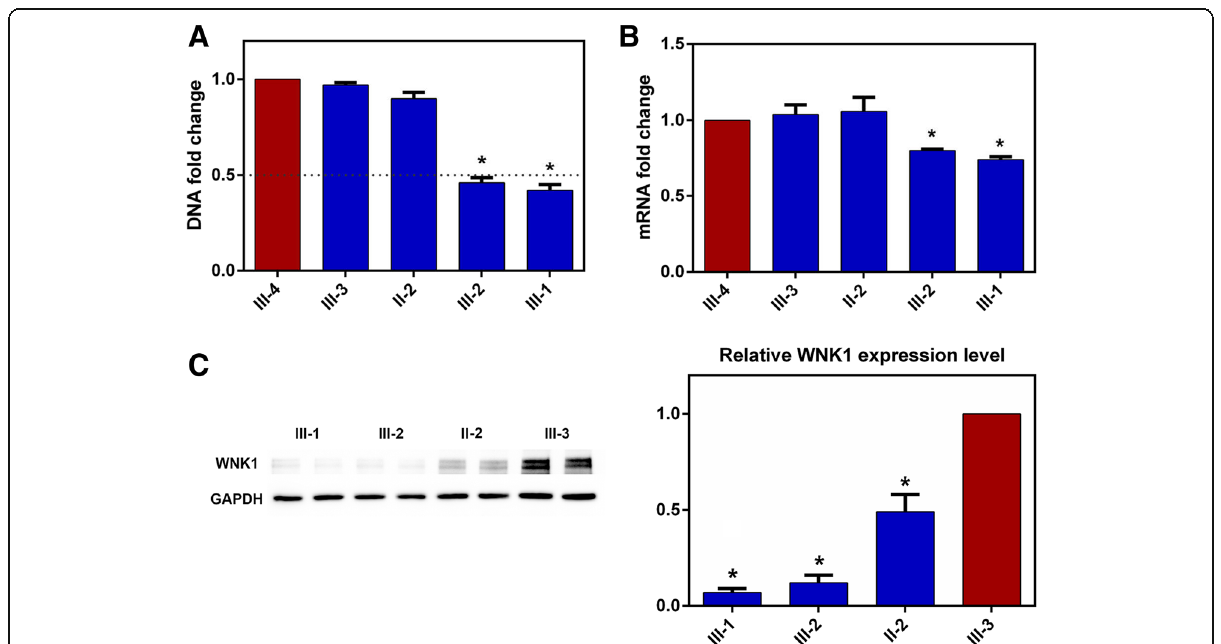
Fig. 2 Quantitative real-time PCR analysis of DNA and mRNA for WNK1 gene and transcript and Western Blot analysis of WNK1 protein. The WNK1 gene dosage was normalized using GAPDH gene as control. a The DNA fold change of the WNK1 gene for the family members. b The RNA fold change of the WNK1 gene for the family members. The WNK1 transcript amount was normalized using GAPDH as housekeeping gene. c The relative WNK1 protein expression level of the family members, using Western Blot. Protein expression was normalized by the use of the housekeeping GAPDH protein level. * indicates p < 0.05 compared with wild type. The error bars refer to standard error (SE) of technical